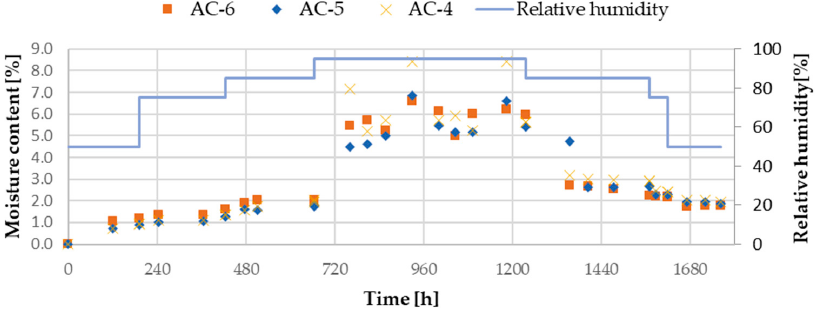
Figure 5. Moisture content of the samples in the desiccators with saturated salt solutions.